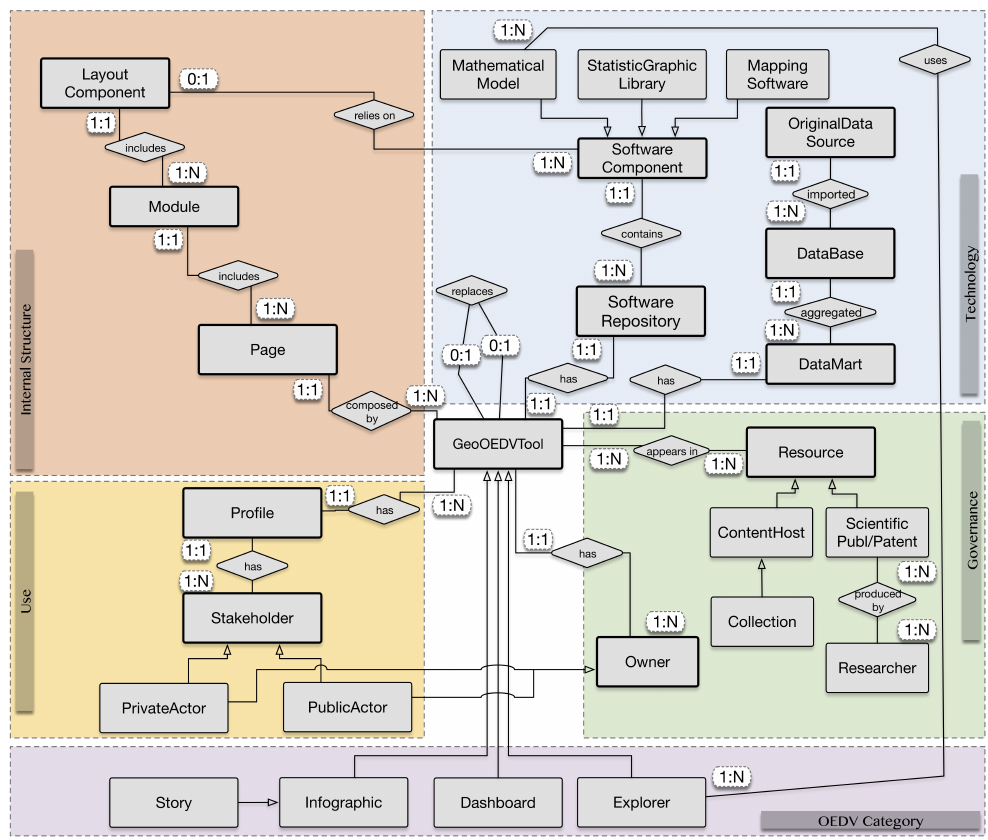
Figure 5. The entity relationship schema of Geo-Online Exploratory Data Visualization tools. Arrows are used to represent generalization relationships; these connect